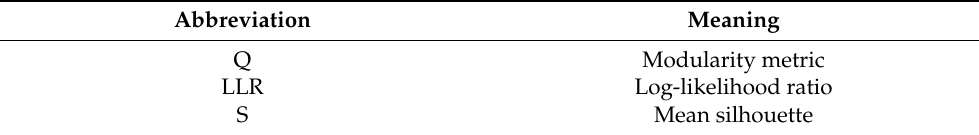
Table 1. List of